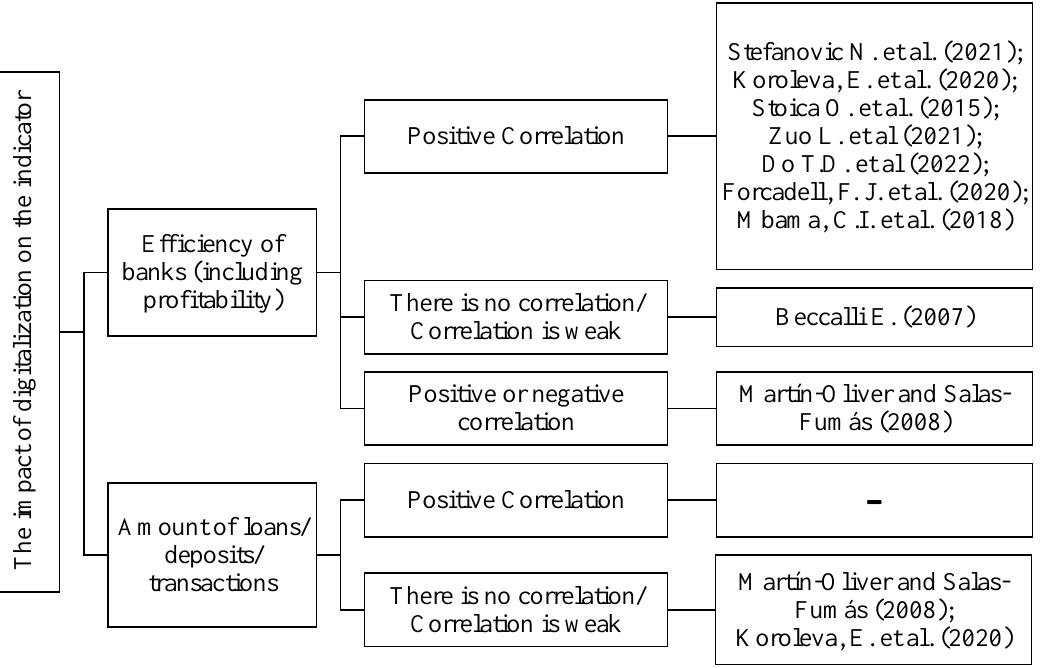
Figure 1. A generalized overview of the results of research on the impact of digitalization on the performance of banks. Source: (Stefanovic et al. 2021; Koroleva and Kudryavtseva 2020; Stoica et al. 2015; Zuo et al. 2021; Do et al. 2022; Forcadell et al. 2020; Mbama et al. 2018; Beccalli 2007; Martín-Oliver and Salas-Fumás 2008).